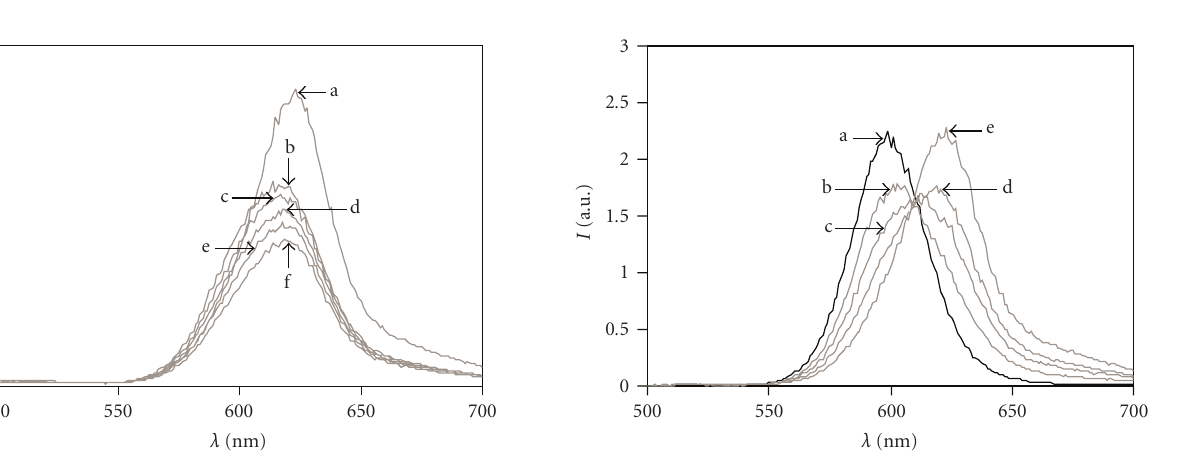
Figure 6: Emission spectra of a mixture of CdSe-ZnS core- shell QDs (0.1 μ M), His 6 -PDK1( Δ PH) (10 μ M) and BODIPY-ATP (10 μ M) in borate bu ff er (pH = 7.4, T = 20 ◦ C, λ EX = 442nm) in the absence (a) and presence of 1 (b), 3 (c), 11 (d), 31 (e), and 301 (f) μ M of ATP.